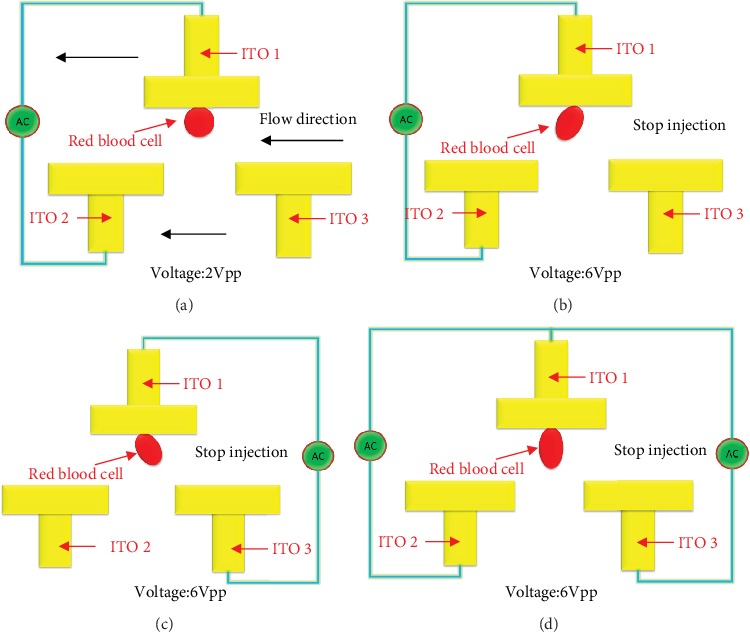
Scheme of the cell-stretching process: (a) the microfluidic syringe pump was on, and a sine wave with 2 Vpp and a frequency of 1.5 MHz was applied to capture the red blood cell on the middle of ITO electrode 1; (b–d) injection of DEP buffer was stopped, and the voltage was increased to stretch the cell in different directions.